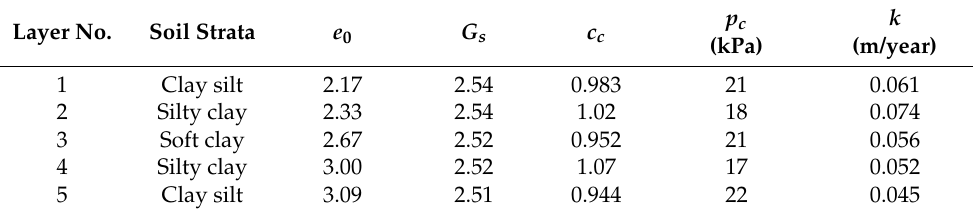
Table 1. Geotechnical